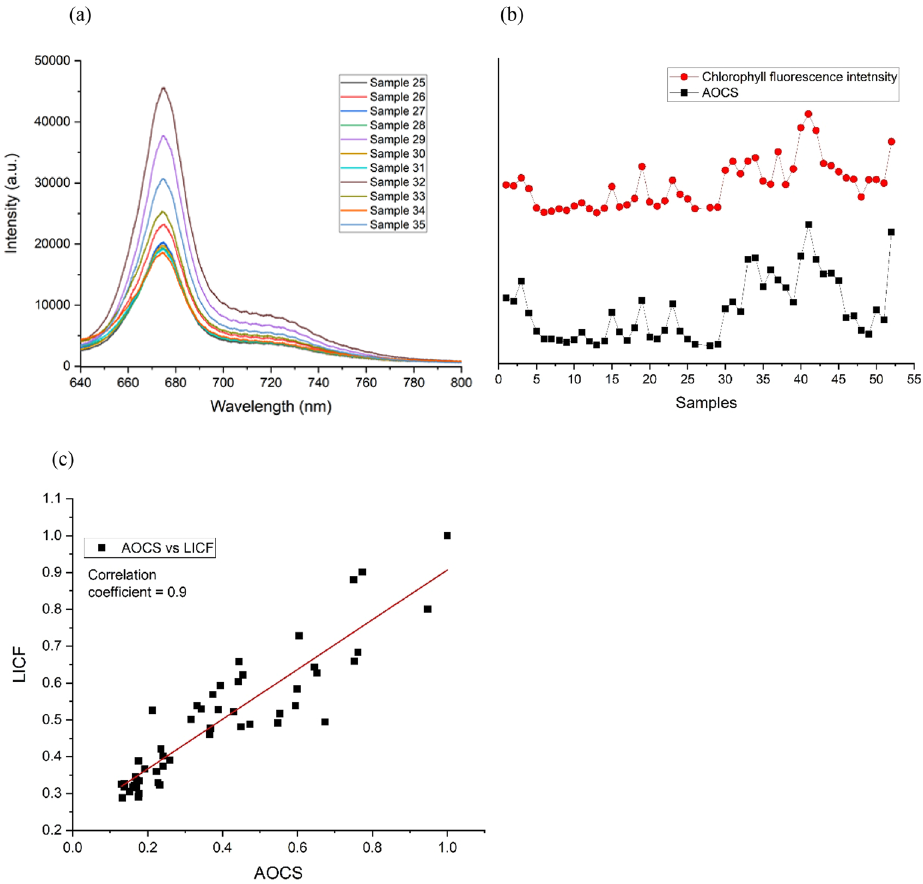
Figure 5. ( a ) Chlorophyll fluorescence spectra acquired from DCO samples collected from the mill. The plot shows 11 out of the 52 samples so that the graph is less cluttered. ( b ) A plot between LICF signal (red) and AOCS analysis (black) of 52 DCO samples. The graphs were normalized and offset for clarity. ( c ) Correlation plot between LICF and AOCS results yields a correlation coefficient of 0.9, suggesting that the LICF is a promising complementary method to